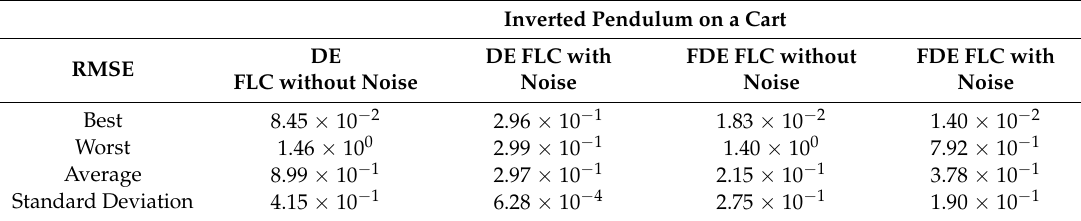
Table 9. Results obtained from the inverted pendulum controller by DE and FDE algorithms.